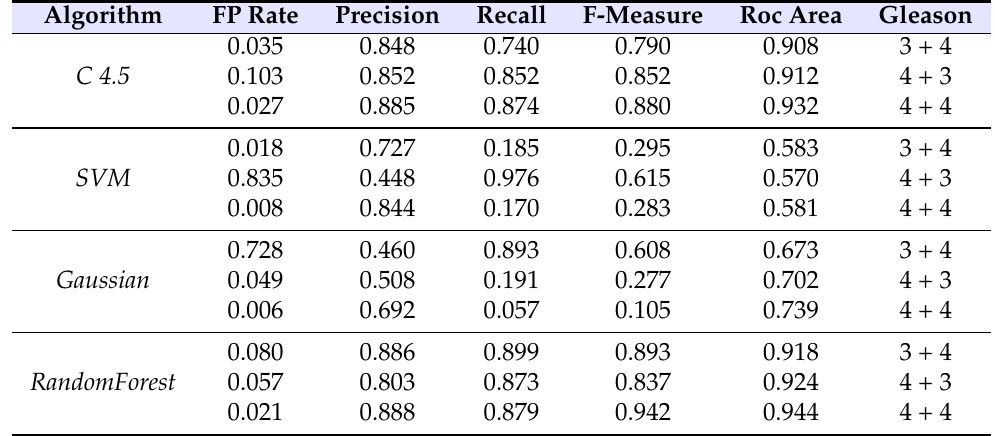
Table 3. Performance